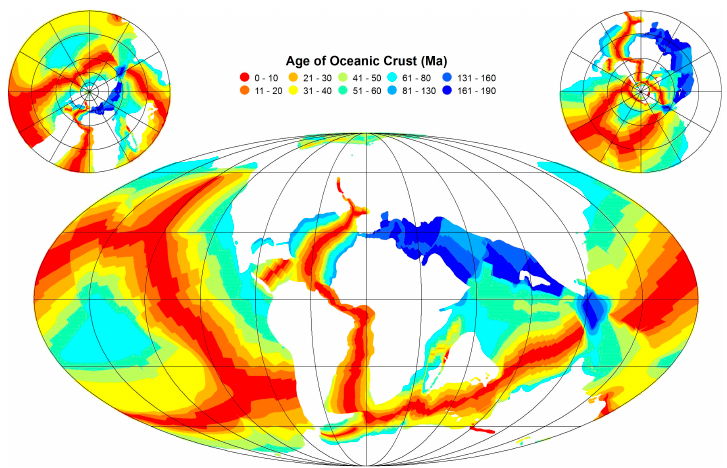
Figure 1. Age of the ocean crust for Cenomanian–Turonian (C–T) time (94 Ma), derived from Müller et al. [15].